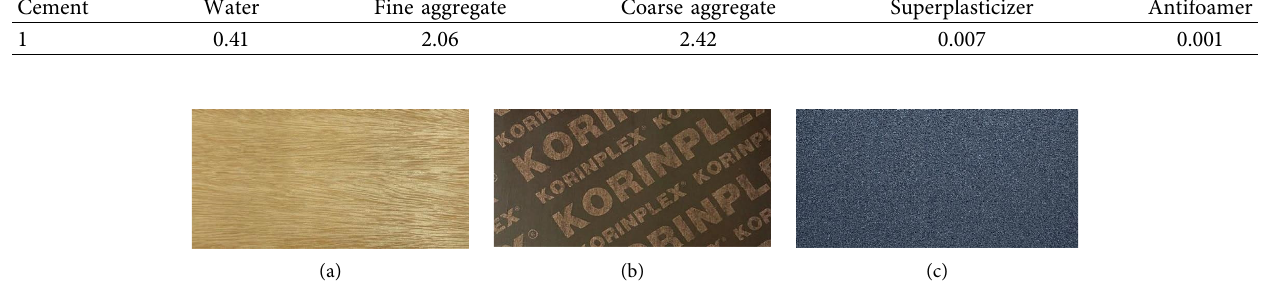
Figure 1: Types of formworks: (a) FN, (b) FC, and (c) FS. Table 2: Adhesive